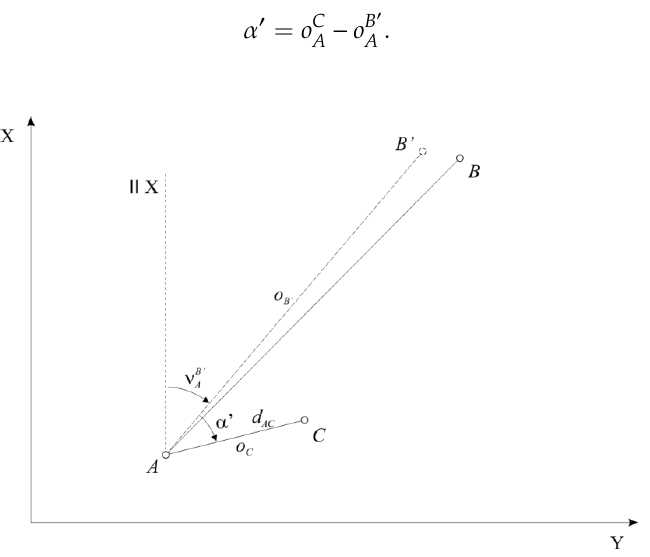
Figure 4. Displacement at orientation point 𝐵 : geometry.